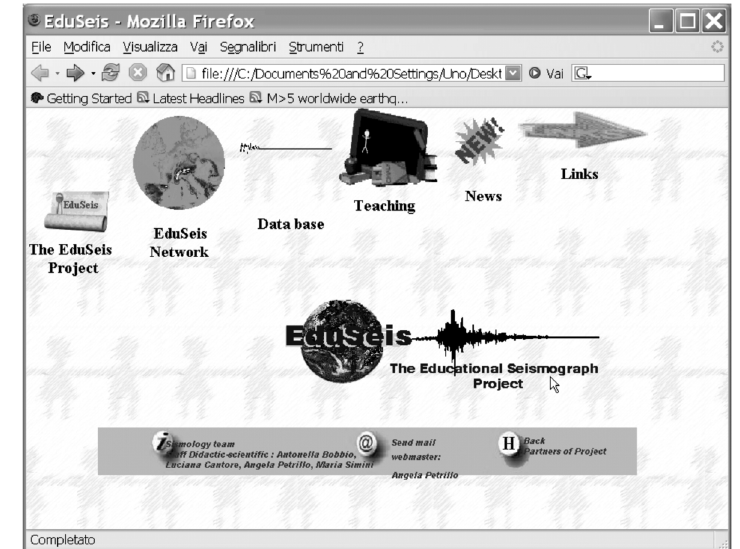
Fig. 1. The EduSeis website